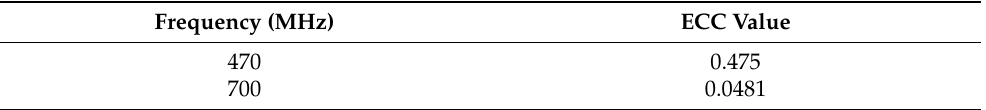
Table 3. Envelope correlation coefficient.